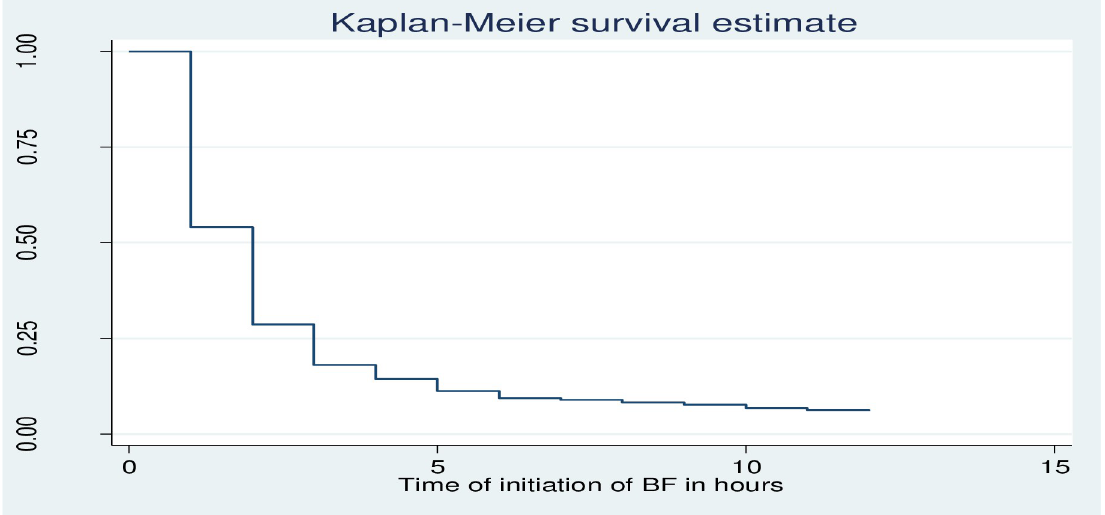
Fig 1. Kaplan-Meier survival estimate of delay to initiate breastfeeding among postnatal mothers within 12 hours of giving birth in Debre Markos Comprehensive Specialized Hospital, North West, Ethiopia, 2020.